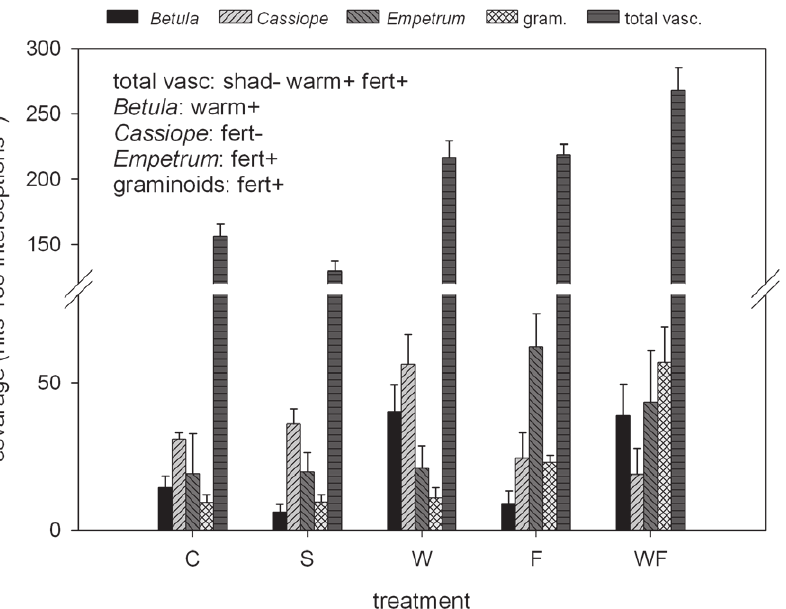
Figure 4. Species coverage in subarctic heath under environmental perturbations. Coverage (mean + 1SE; n=6) of the shrubs Cassiope tetragona , Empetrum hermaphroditum and Betula nana , the graminoids (gram.) and of the total vascular species (total vasc.) at a subarctic heath in Abisko (Northern Sweden) after 22 years of environmental manipulation: shading (S), warming (W), fertilisation (F), combined warming plus fertilisation (WF). Text on the top left indicates the environmental factors with a significant impact on coverage (shad: shading; warm: warming; fert: fertilisation, and warm 6 fert: warming 6 fertilisation) and their direction ( + : positive, 2 : negative).